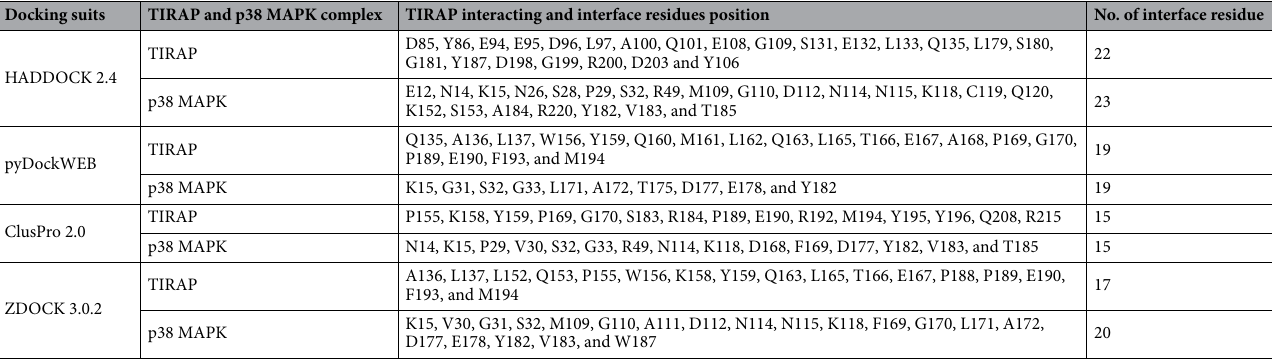
Table 1. The interacting residues of TIRAP and p38 MAPK were identified using the UCSF Chimera v1.13.1 and PDBePISA within the 3 Å region. The p38 MAPK phosphorylation site Y182 in the kinase domain is involved in the interaction at the interface while the tyrosine-phosphorylation sites of the TIRAP TIR domain are involved on the other